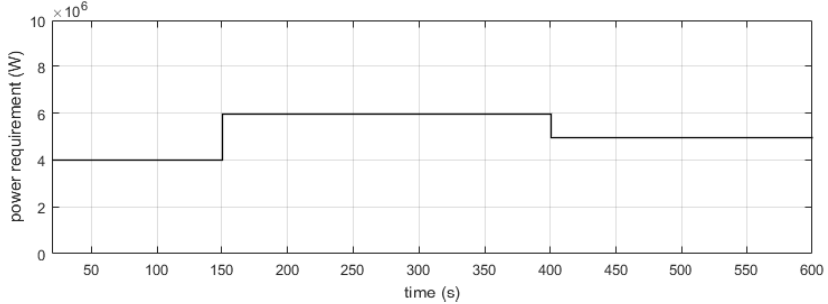
Figure 16. The TSO order.